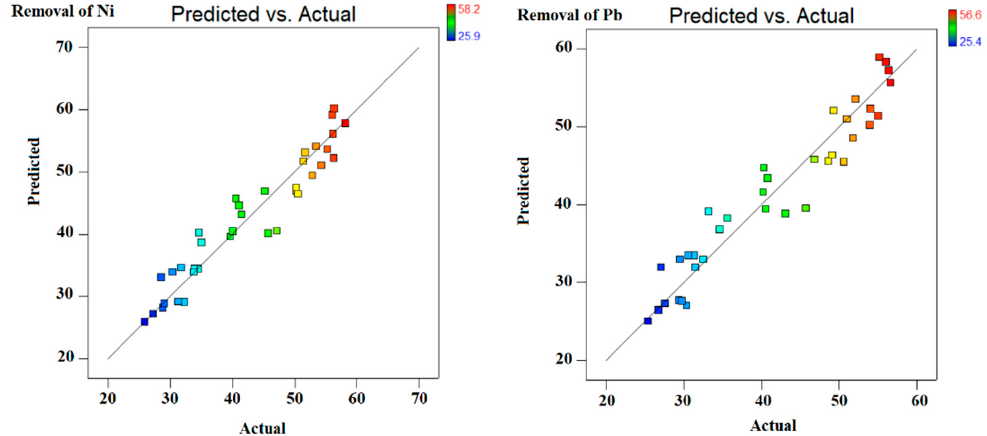
Figure 6. Design expert statistical plots for removal of Ni and Pb.